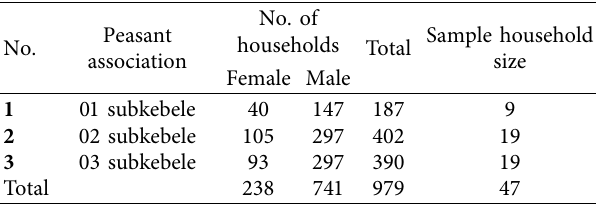
Figure 1: Geographical map showing the location of the study site. Table 1: Household sample size proportion to peasant association of study